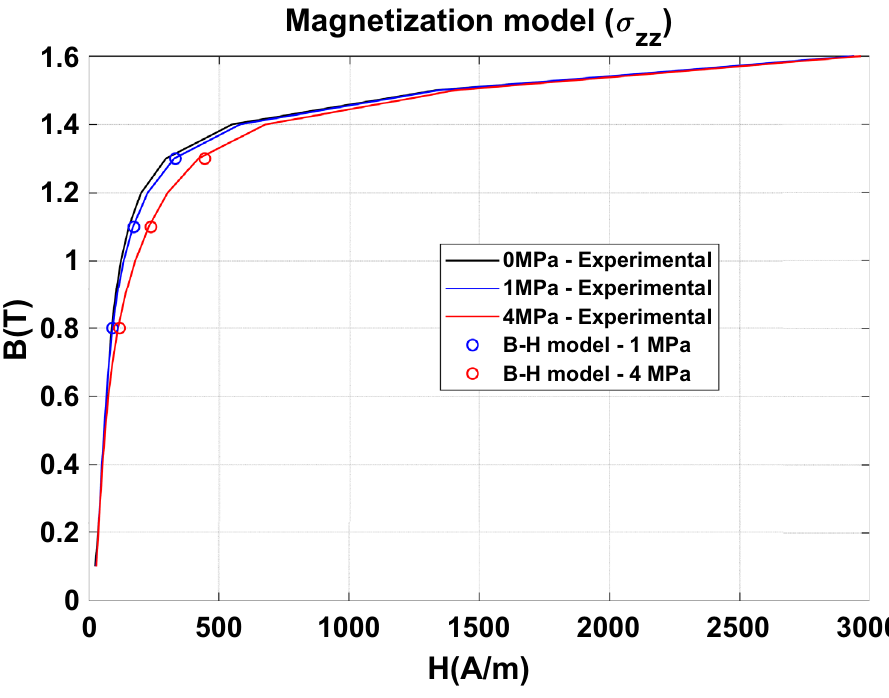
Figure 31. Comparison between experimental and numerical results on normal magnetization curve.